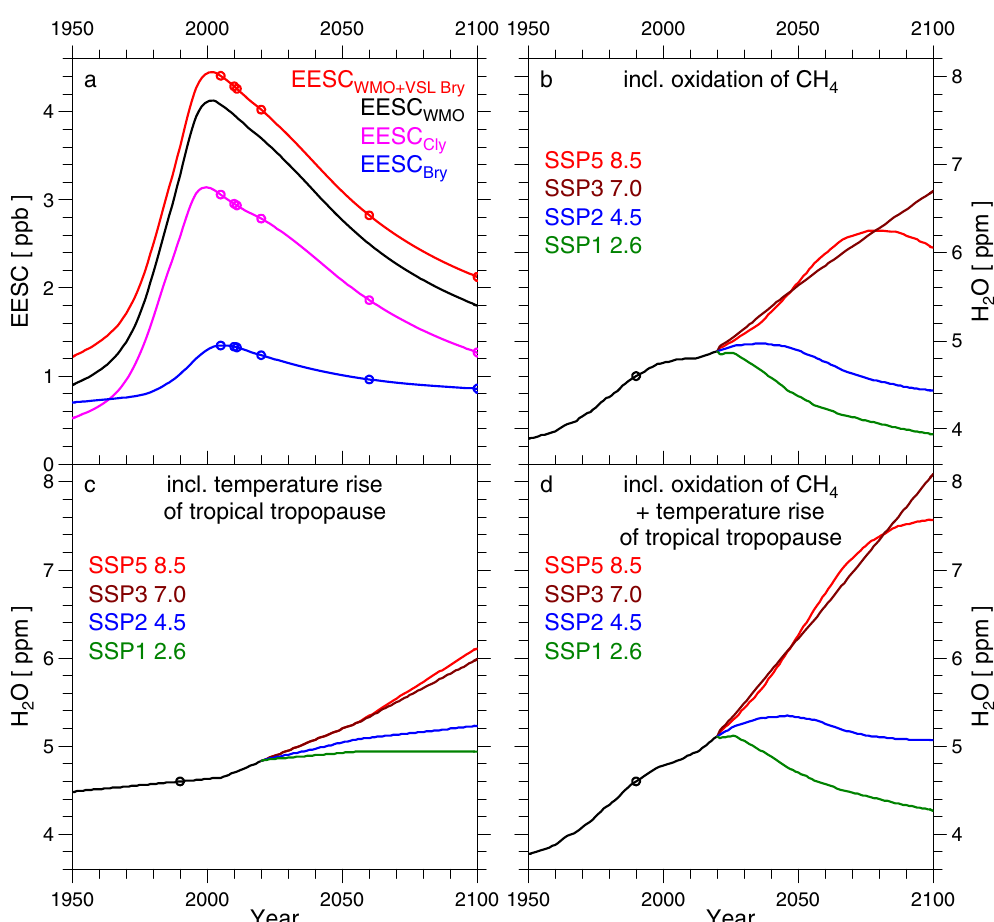
Fig. 2 Polar Stratospheric EESC and H 2 O. a EESC (equivalent effective stratospheric chlorine) for the polar stratosphere computed using fractional release factors from Newman et al. 30 and values of the abundances of long-lived halogen source gases from Table 6-4 of most recent WMO Ozone Assessment Report 28 (black line). Throughout, we use a slightly modi fi ed version of polar EESC, found by accounting for a 5 ppt contribution from very short-lived (VSL) bromocarbons 29 (red line; circles denote years of the ATLAS simulations shown in Fig. 1). The contribution to this modi fi ed polar EESC from stratospheric chlorine and bromine are shown by the violet and blue lines, respectively. b – d polar stratospheric H 2 O (in several SSP scenarios) found accounting for: variations in atmospheric CH 4 ( b ); the temperature rise of the tropical tropopause layer (TTL) ( c ); both CH 4 and warming of the TTL ( d ) (see “ Methods ” ). The circle denotes H 2 O = 4.6 ppm, used to compute PFP whenever time-invariant H 2 O is speci fi ed. (Historical part: black lines; SSP1-2.6: green lines; SSP2-4.5: blue lines; SSP3-7.0: brown lines; SSP5-8.5: red